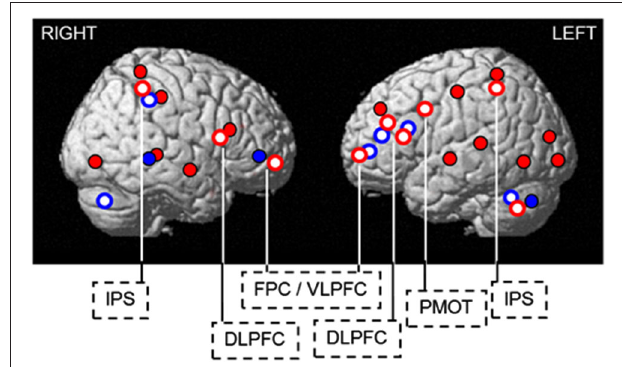
FIGURE 5 | Endogenous and exogenous regulation of sleep and wakefulness affects cognitive brain responses through overlapping pathways . Blue light increases cognitive brain responses in regions showing decreased activation ( PER3 5 / 5 ) or compensatory recruitment ( PER3 4 / 4 ) in darkness, following sleep loss. Blue solid: compensatory increase in activation in the morning hours after 25 h of wakefulness in PER3 4 / 4 , found in the ventrolateral prefrontal cortex, temporal cortex, cerebellum, and thalamus (not shown). Red solid: decreases in activation in the morning hours after 25 h of wakefulness in PER3 5 / 5 , observed in the occipital, temporal, parietal, and lateral prefrontal cortices. Red open: blue light-induced increase in activations after 25 h of wakefulness in PER3 5 / 5 (thalamus not shown). Blue open: blue light-induced increase in activity after 1.5 h of wakefulness in PER3 4 / 4 . DLPFC = dorsolateral prefrontal cortex; FPC / VLPFC = frontopolar / ventrolateral prefrontal cortex; IPS = intraparietal sulcus; PMOT = premotor cortex. [Copied with permission from Vandewalle et al.